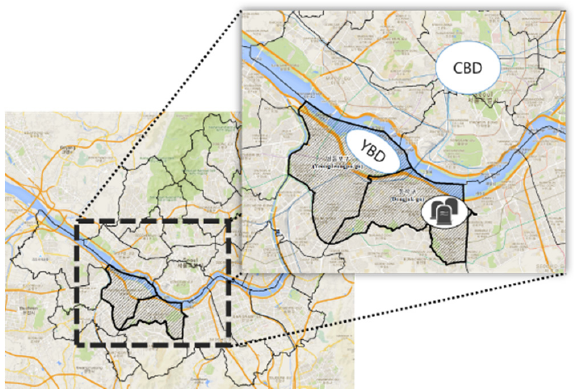
Figure 2. Study area in a hatched symbol.